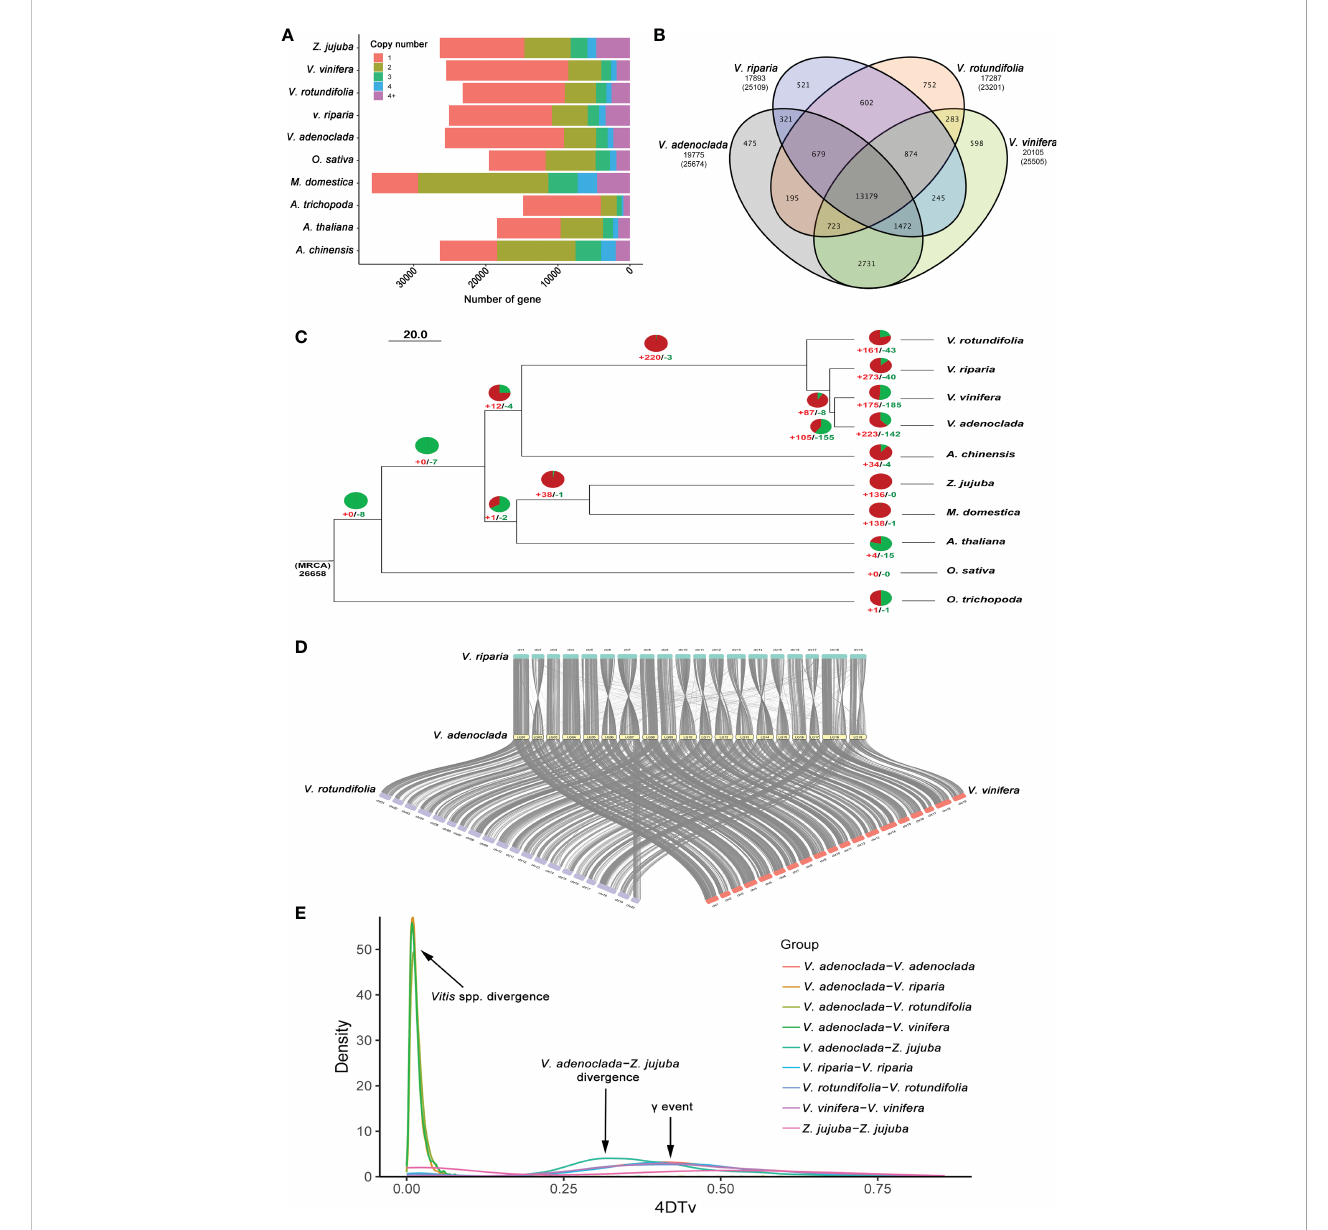
FIGURE 2 Comparative genomics analysis of V. adenoclada and other representative plant species. (A) Gene copy number distribution in V. adenoclada and nine other plant species. (B) Venn diagram of gene families in V. adenoclada and the other three grapes. (C) Phylogenetic analysis, gene family expansion/ contraction analyses and branching time approximations. Green and red represent the number of gene family contraction and expansion occurrences, respectively. Branching times (Mya) are denoted by the numbers adjacent to the nodes. (D) Genome collinearity analyses between V. adenoclada and the other three grapes of V. vinifera , V. riparia , and V. rotundifolia . (E) Distribution of 4DTv among V. adenoclada , V. vinifera , V. riparia , V. rotundifolia , and Z. jujuba in intra- and intergenomic